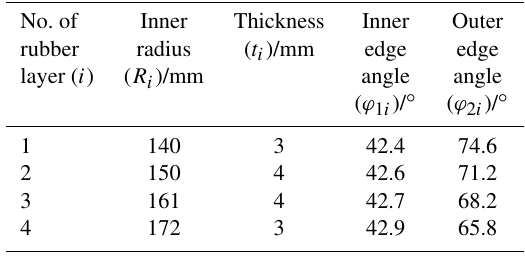
Table 1. Geometric parameters of rubber layers. No.